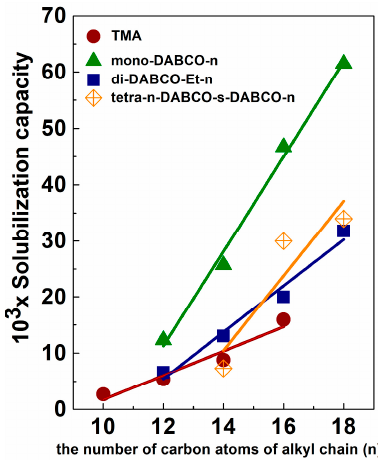
Figure 4. The solubilization capacity of micellar aggregates based on quaternized derivatives of DABCO and trimethyl ammonium (TMA) analogs toward the dye Orange OT.